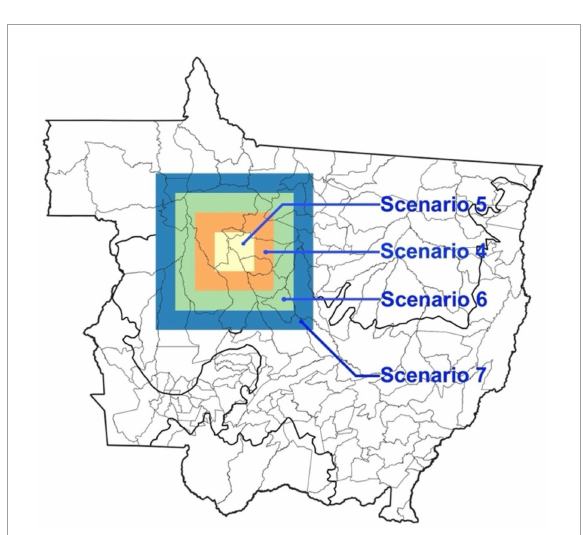
FIGURE16 Proposed scenarios with different box sizes: Scenario 5